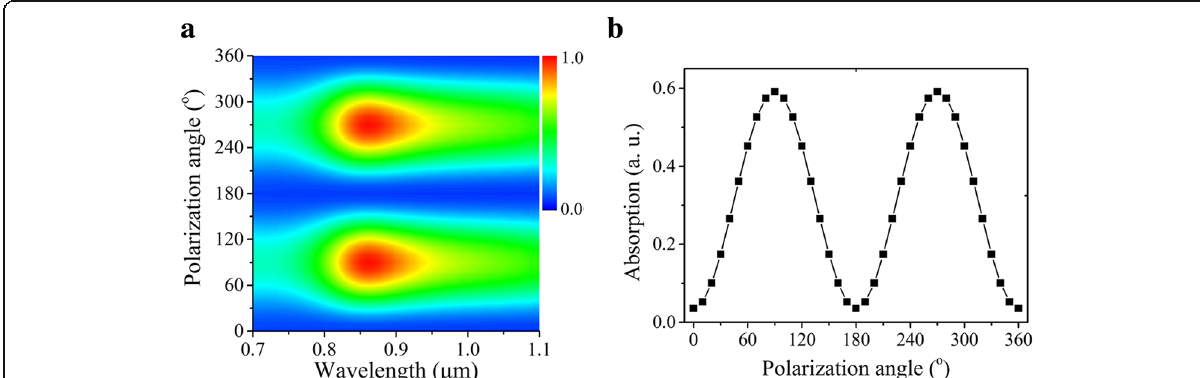
Fig. 3 The theoretical results for the polarization properties of the photodetector with the surface plasmonic resonator. a The polarization dependence of optical absorption spectra at different polarization angle. The 0°of polarization angle was defined along the direction of the Au grating. b Polarization-dependent absorption intensity with incident wavelengths of 860 nm